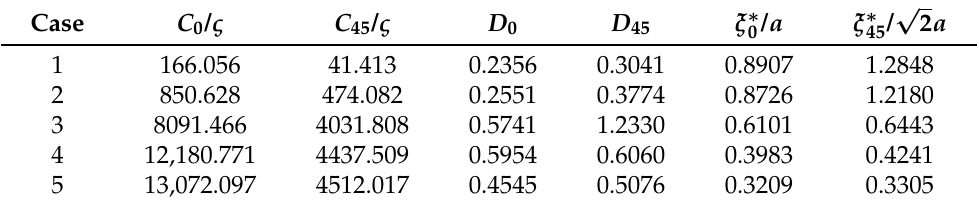
Table 2. Input parameters for the radial shear traction function from Equation (2), corresponding to the five normal traction loading cases (N1–N5) examined in this study. The peak traction ratio ς is further parametrized in order to study the effect of the magnitude of frictional shearing forces, which may develop at the contact